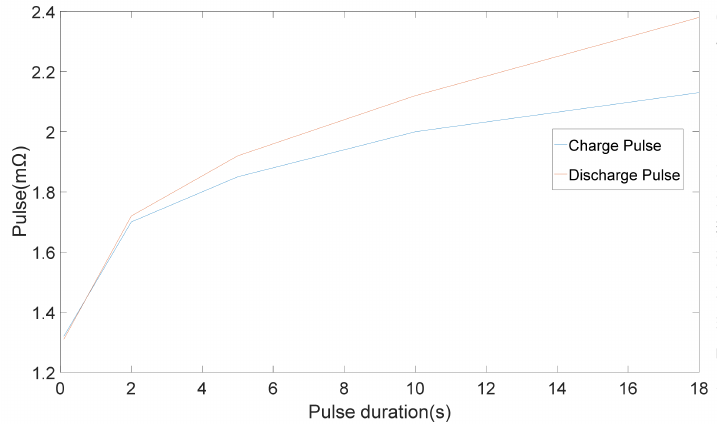
Figure 3. Variation of internal resistance with pulse period [11].